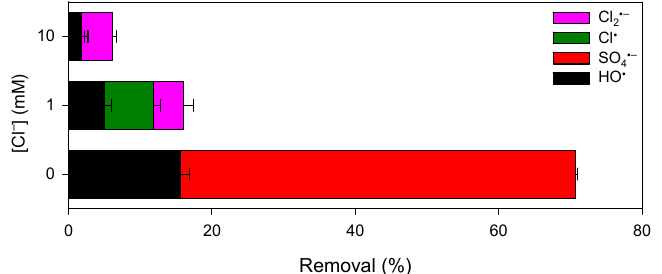
Figure 7. Influence of Cl − on CBZ degradation by the Mn(III)/HSO 3 − process. [CBZ] 0 = 5 µM, [Mn(III)] 0 = 50 µM, [HSO 3 − ] 0 = 250 µM, [PP] = 2.5 mM, pH = 7.0.